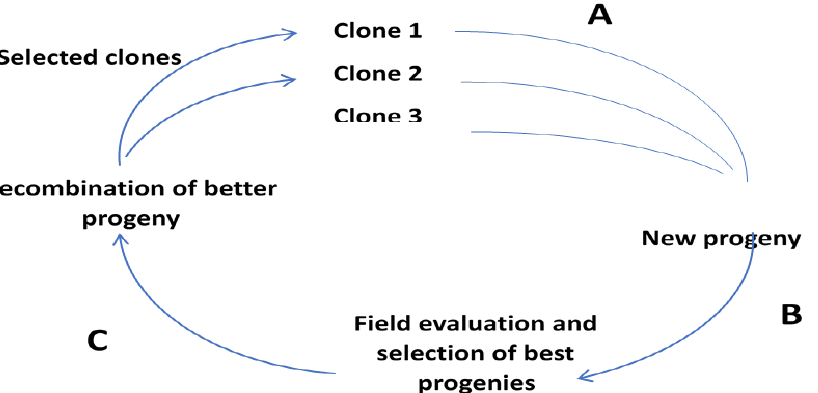
Figure 2. General diagram of the recurrent selection (RS) process in Robusta coffee. The cycle begins with the crossing of a group of clones (A); the derived progeny is evaluated in different environments to select the best individuals; (B) the individuals are crossed with each other to produce a new population from which the best clones are identified; (C) the process begins again with a new group of improved clones.